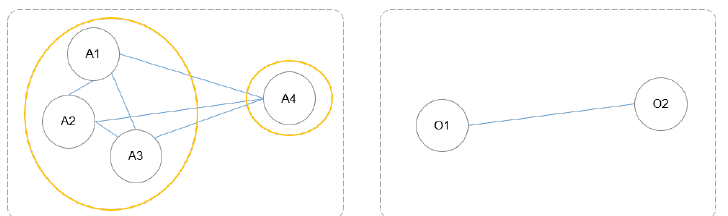
Figure 12. Operation, Roll-up, and Drill-down for topological on-line analytical analysis